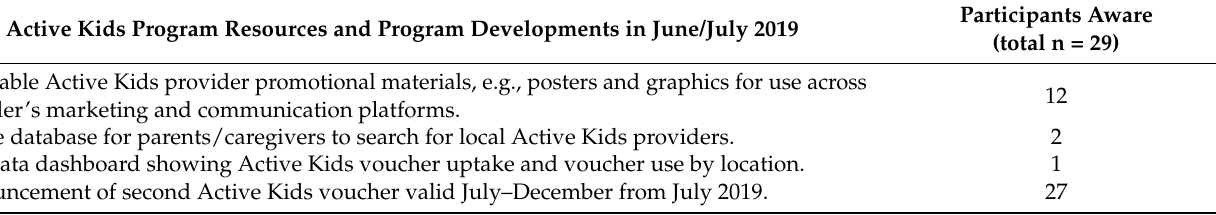
Table 2. Active Kids provider awareness of additional resources to aid